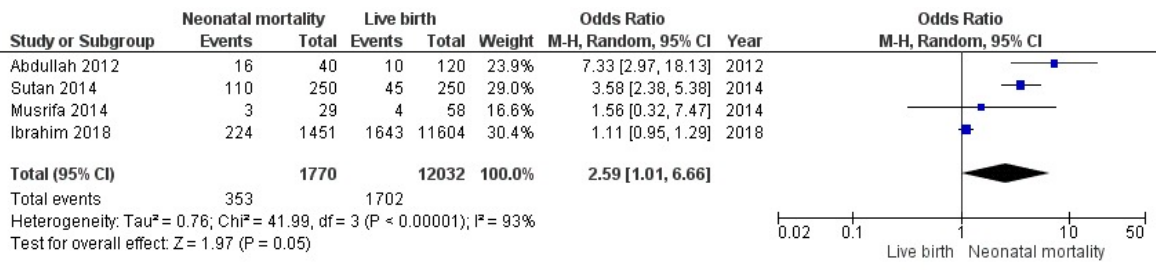
Figure 2. Association between passive smoking, active smoking, incomplete ANC, and LBW.